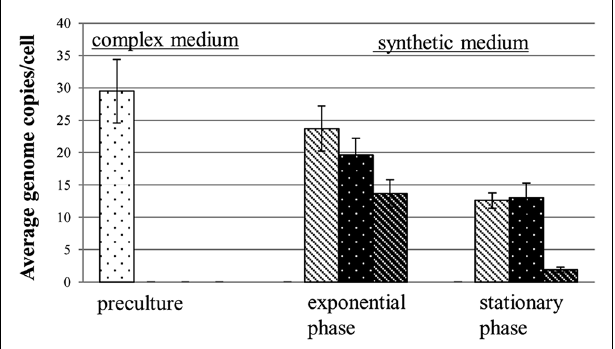
FIGURE 2 | Chromosome copy numbers of H. volcanii cells grown in synthetic media with two different phosphate concentrations and in the absence of external phosphate. The copy numbers were quantified during mid-exponential growth phase and at stationary phase, as indicated (taken from Zerulla etal.,